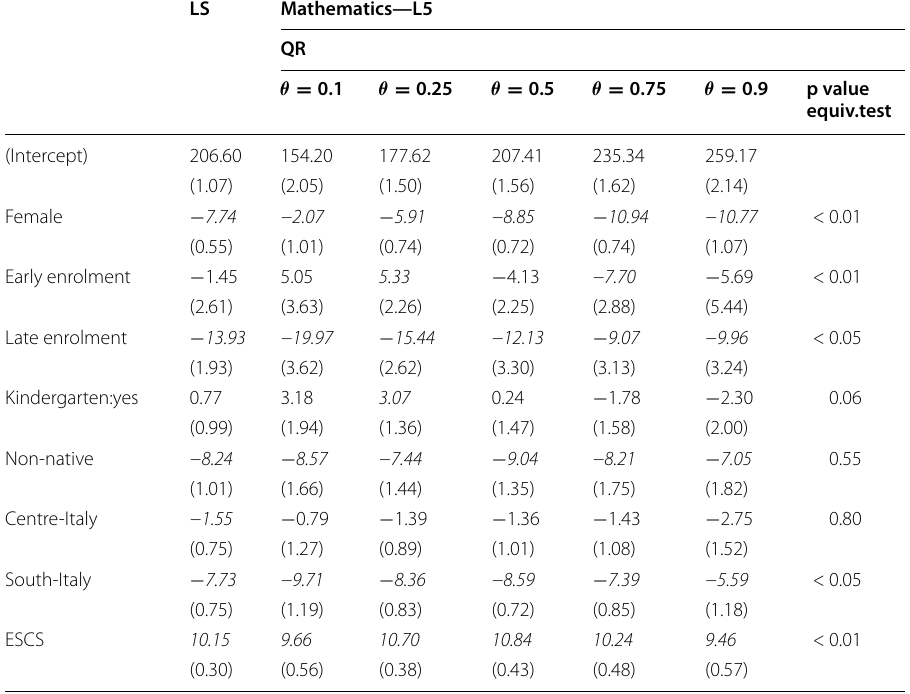
Table 5 LS and QR estimates of the effects of covariate on mathematics achievement in primary school—fifth